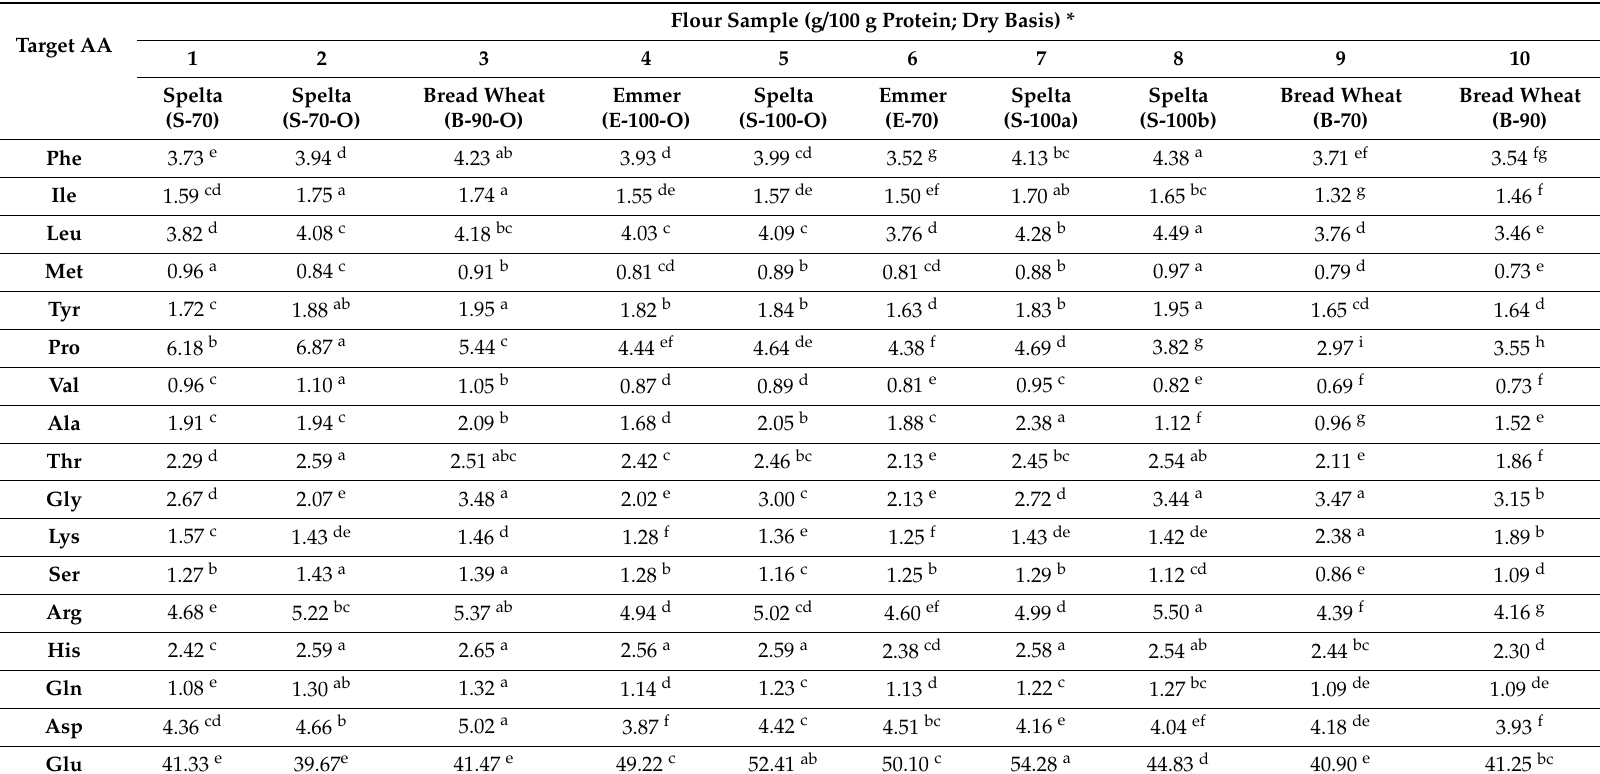
Table 3. Average amino acids composition (g / 100 g protein) of wheat flours under